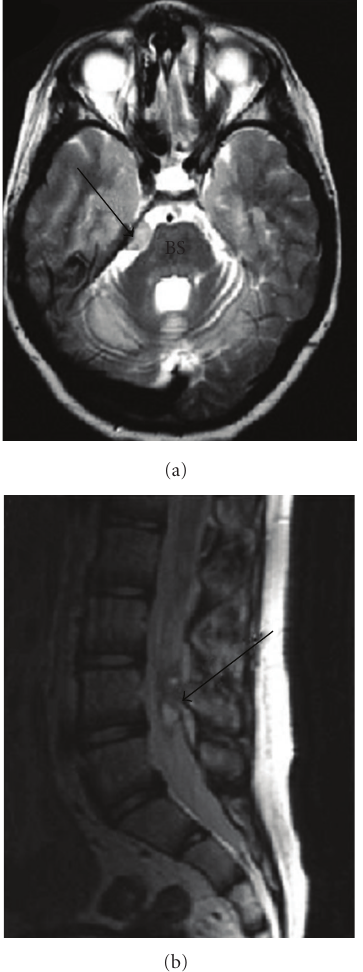
Figure 1: (a) Brain MRI demonstrating a lesion (arrow) based on the tentorium next to the brain stem (BS). (b) Spinal-lumbar MRI (T2) showing an intradural lesion (arrow) at the level of the L4 vertebra. Reproduced with